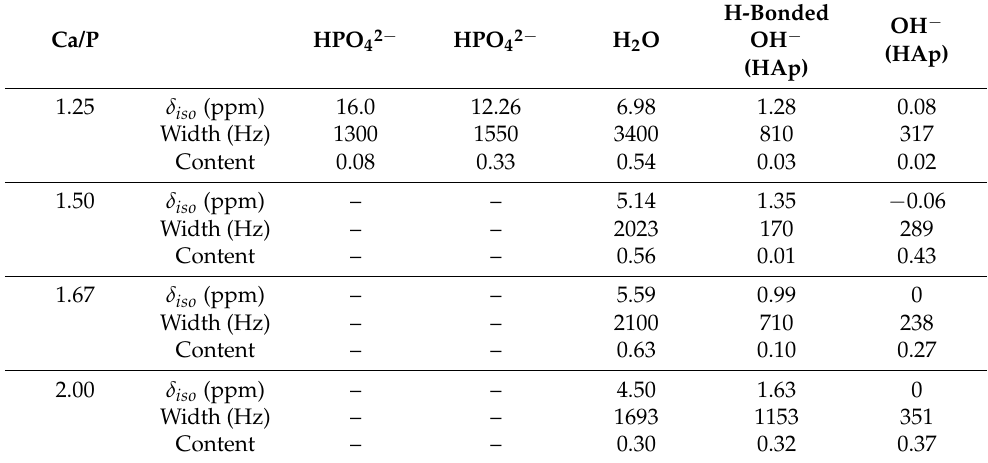
Table 4. 1 H chemical shift parameters for the synthesized